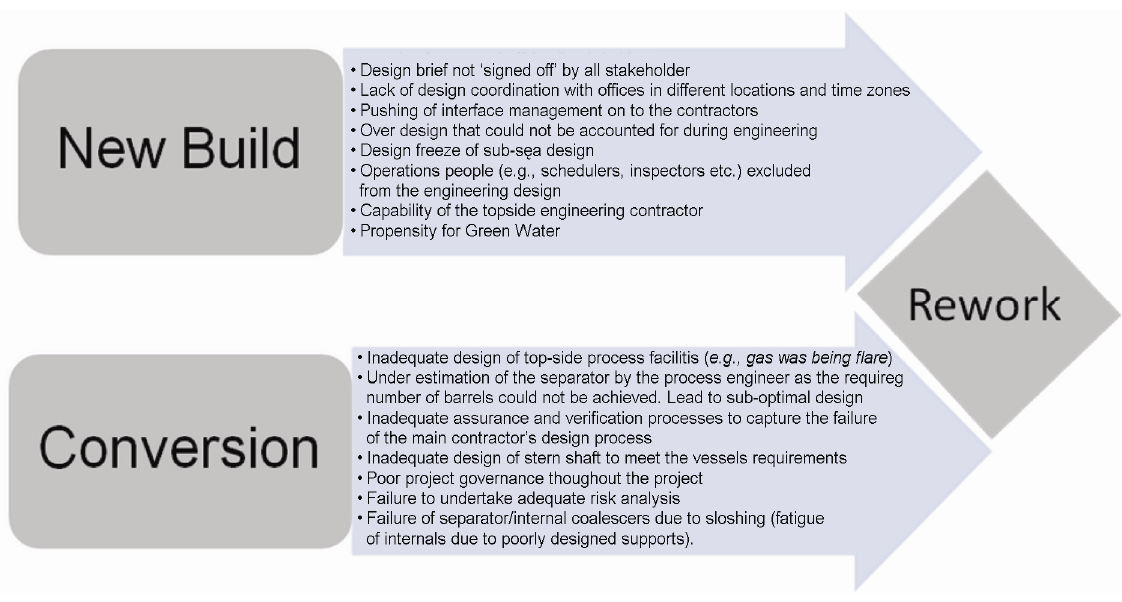
Fig. 5. Key factors contributing to rework for new build and conversion